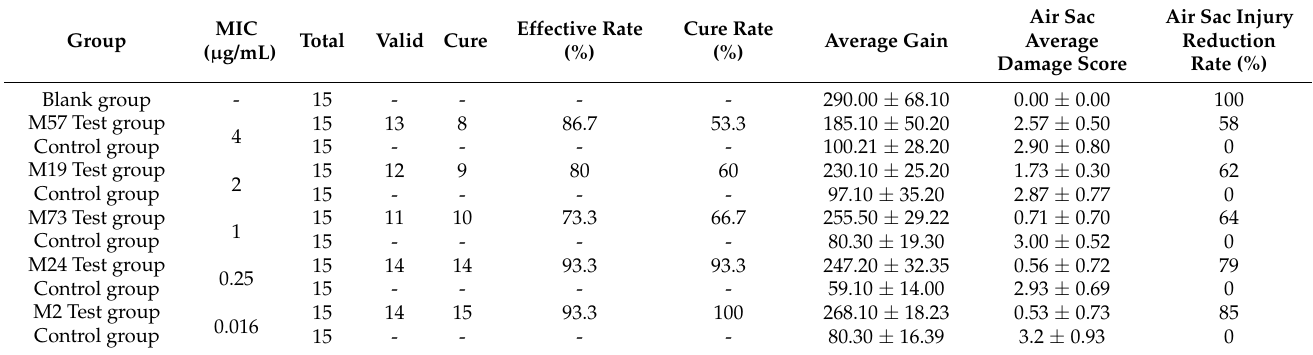
Table 4. The effect of danofloxacin for the treatment of different MIC of MG